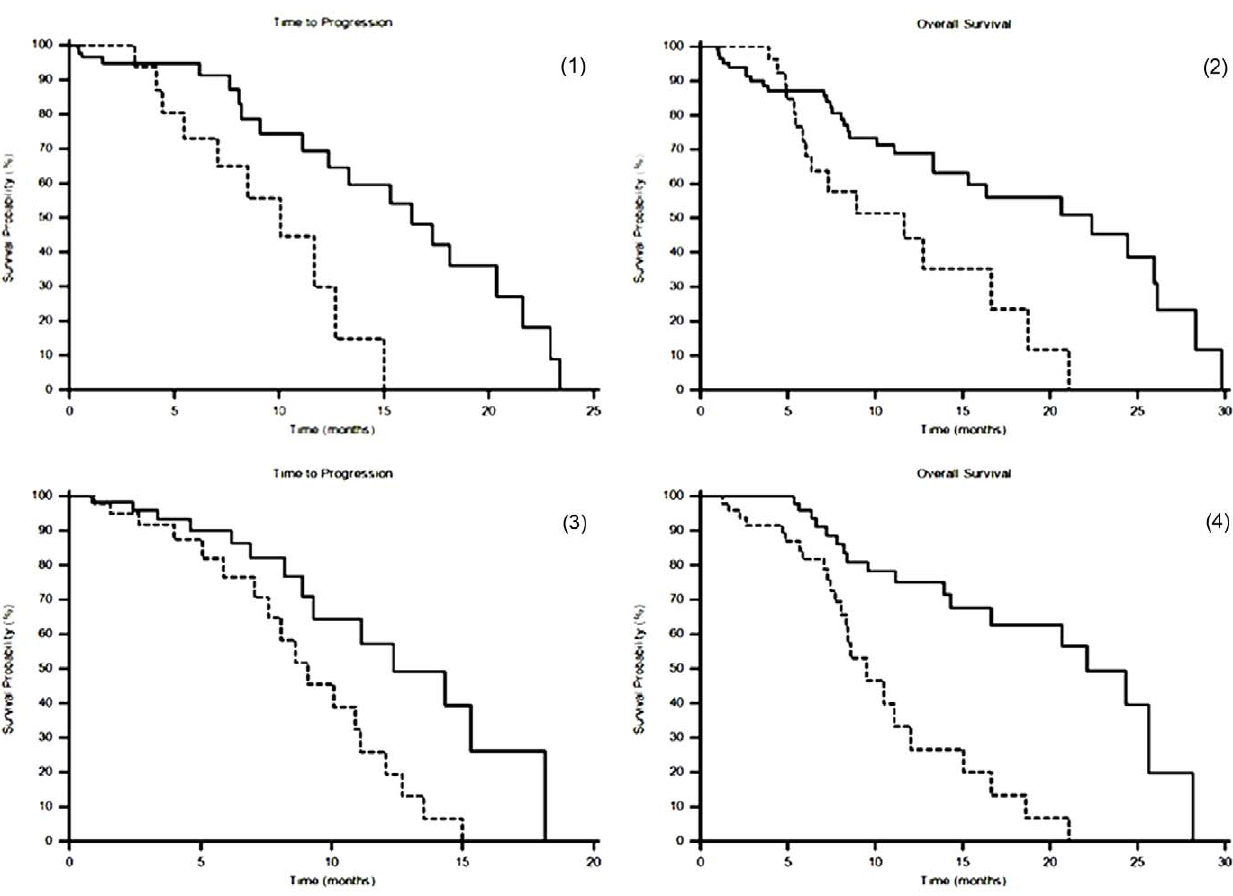
Figure 1. Survival analysis according to lactic dehydrogenase (LDH) serum levels in HCC patients undergoing transarterial- chemoembolization. Panel 1) Median time to progression (TTP) according to LDH serum levels: LDH # 450 U/l (–––), LDH . 450 U/l (--------) (p=0.0085). Panel 2) Median overall survival (OS) according to LDH serum levels: LDH # 450 U/l (–––), LDH . 450 U/l (--------) (p=0.0049). Panel 3) Median TTP according to the LDH serum levels variations pre- and post-treatment: LDH decreased post-treatment (–––), LDH increased post- treatment (--------) (p=0.0087). Panel 4) Median OS according to the LDH serum levels variations pre- and post-treatment: LDH decreased post- treatment (–––), LDH increased post-treatment (--------) (p , 0.0001).